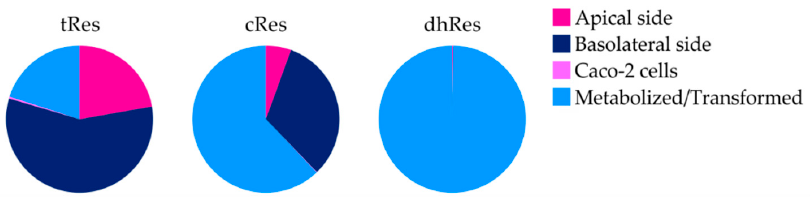
Figure 3. Fate of parent compounds in Transwell TM cellular system (% mol).